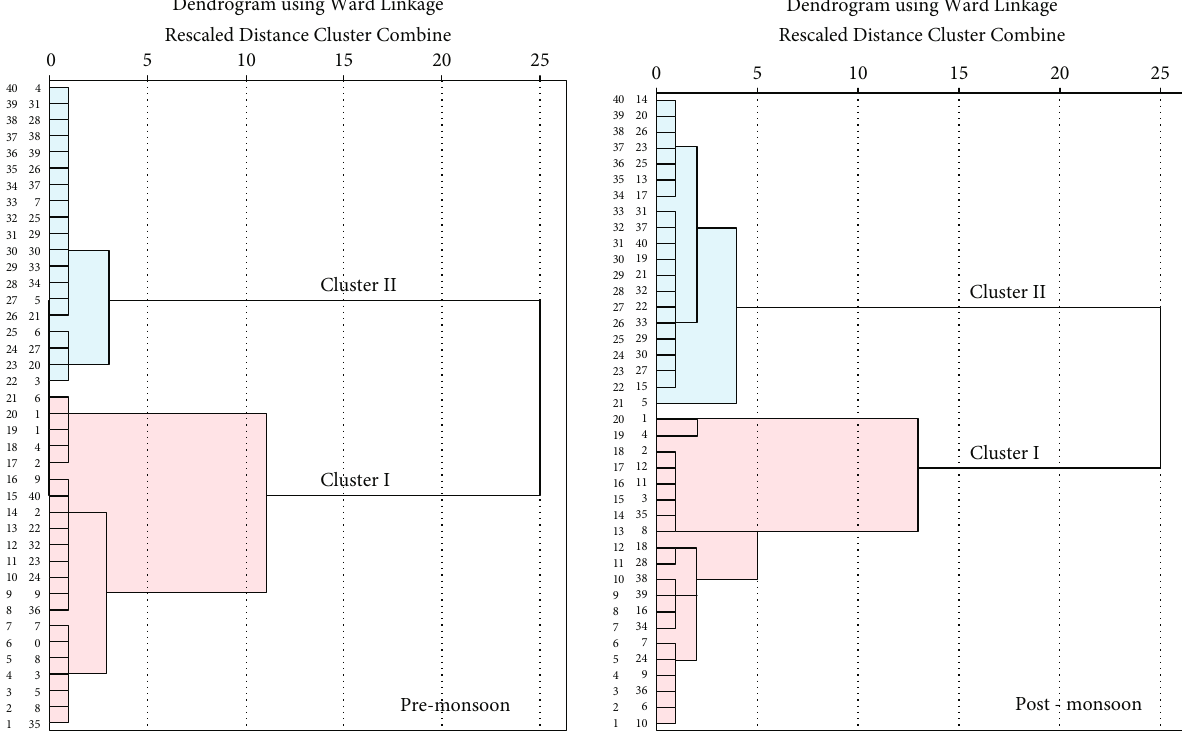
Figure 7: Hierarchical cluster analysis of 40 sampling stations for both PRM and POM sampling seasons. Dendrogram of Q-mode hierarchical cluster analysis (HCA) showing associations between samples from di ff erent parts of the hydrologic system ( x -axis: subgroups of samples with the number of samples in parentheses; de fi nitions are in Table